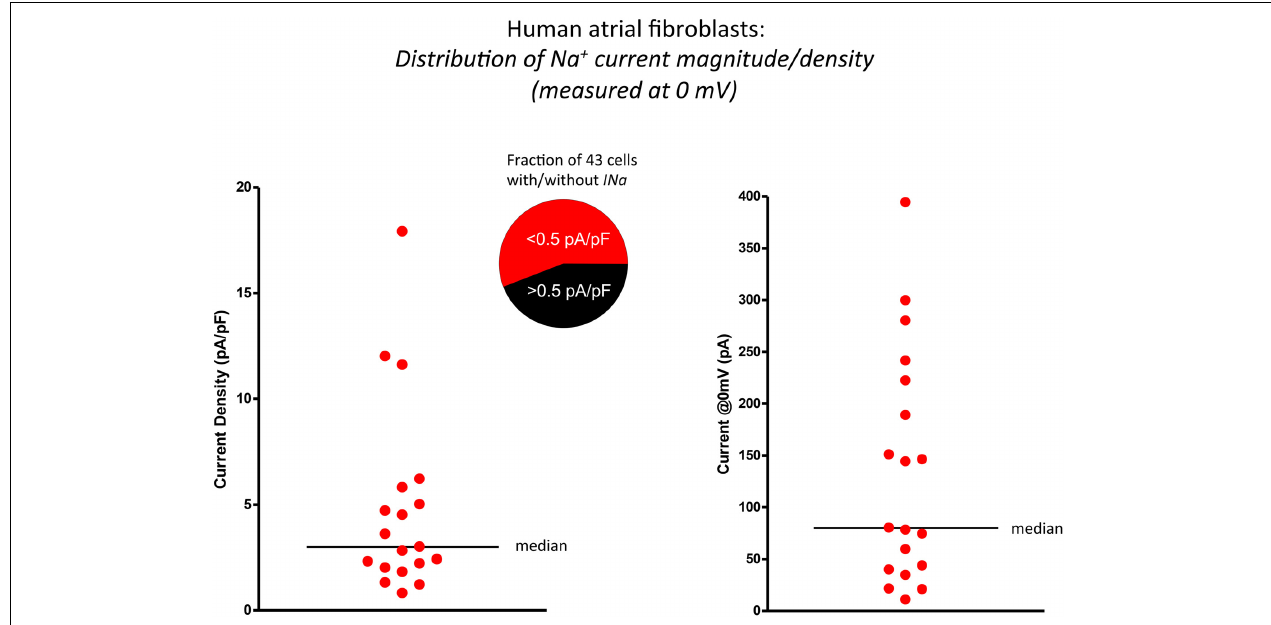
FIGURE 2 | Scatter plots illustrating the significant range of values of functional Na + current expression in isolated human atrial myofibroblasts ( n = 19 cells). The data in the left panel summarizes these findings as current densities, i.e., by expressing I Na values (recorded in